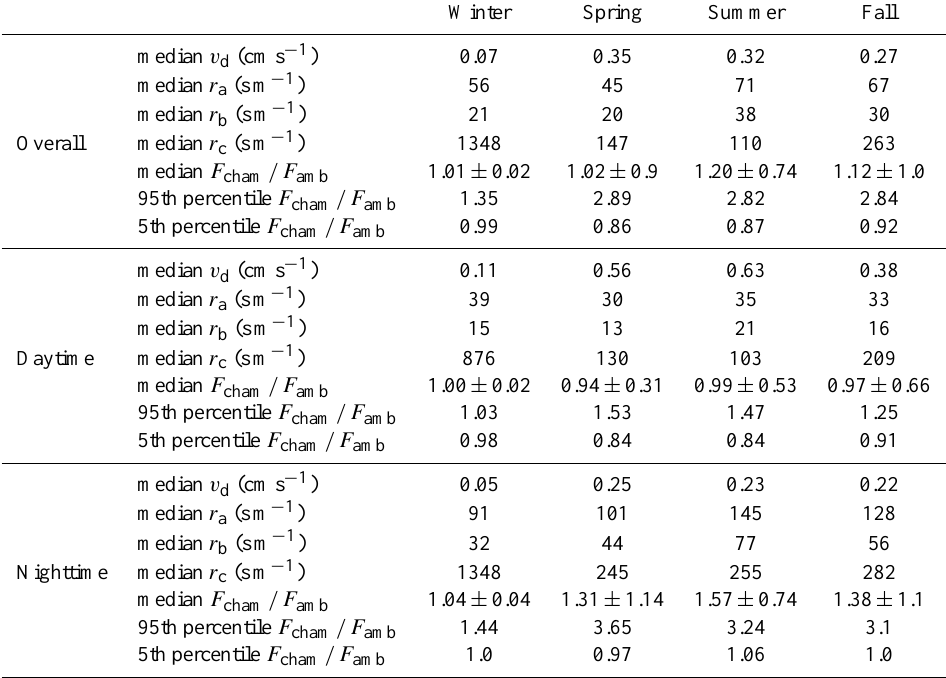
Table 3. Seasonal mean resistance, correction factor, and deposition